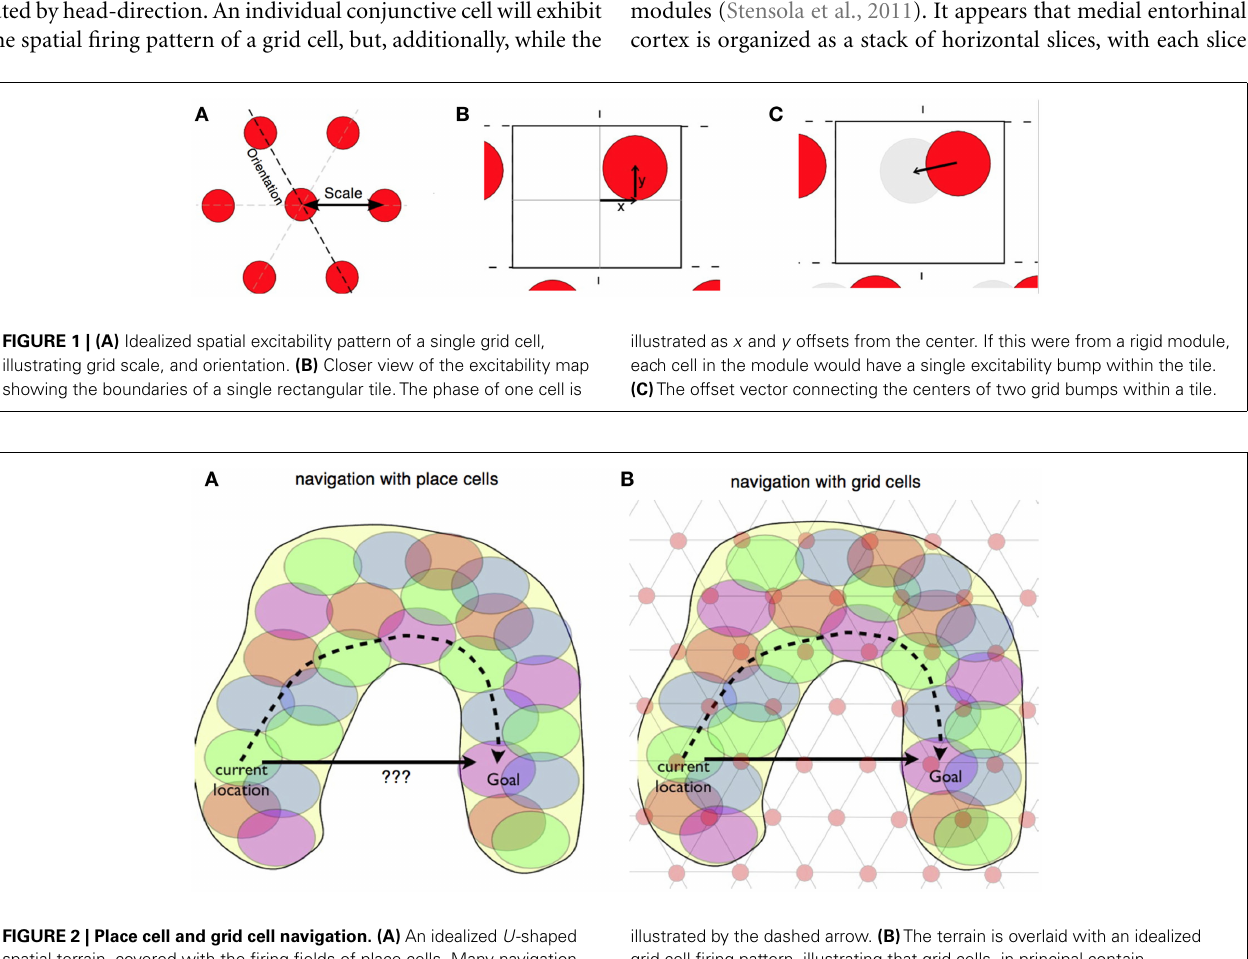
illustrated by the dashed arrow. (B) The terrain is overlaid with an idealized grid cell firing pattern, illustrating that grid cells, in principal contain information for a linear, shortest-path route between start location and goal.The path can cross unvisited